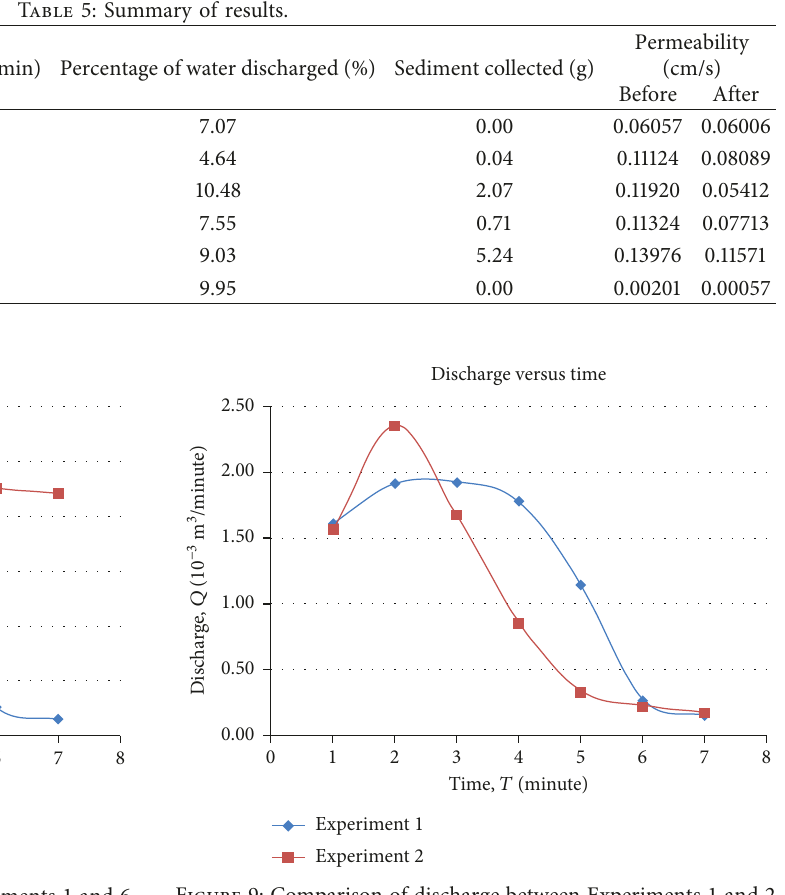
Figure 8: Comparison of discharge between Experiments 1 and 6 for the first 7 minutes.